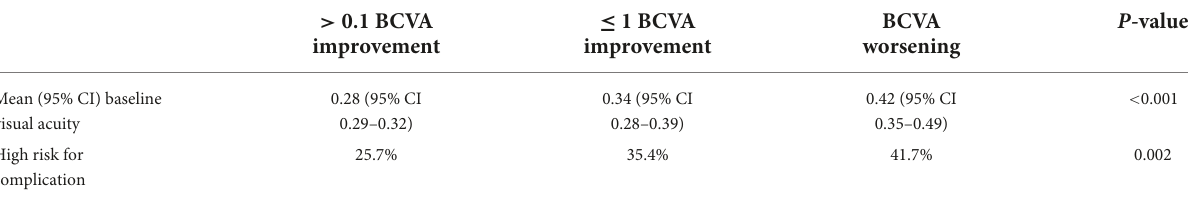
TABLE 4 Comparison between best corrected visual acuity (BCVA) improvement by > 0.1, ≤ 0.1, and worsening in terms of mean baseline visual acuity and complication risk among the three